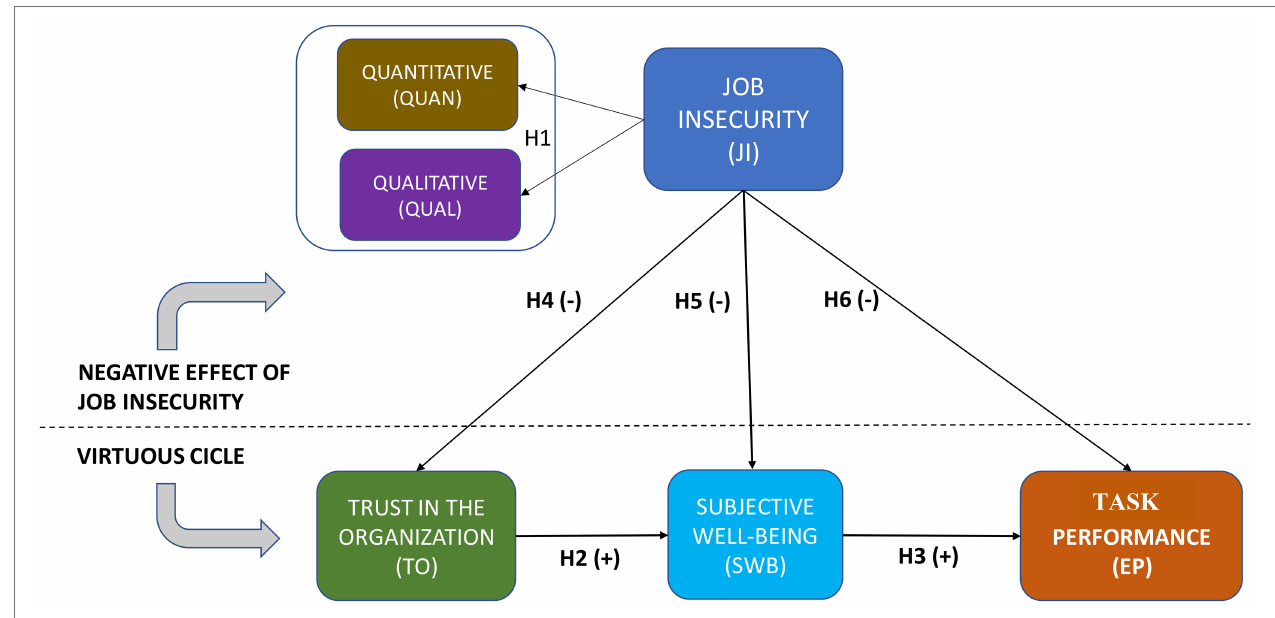
FIGURE 1 | The theoretical